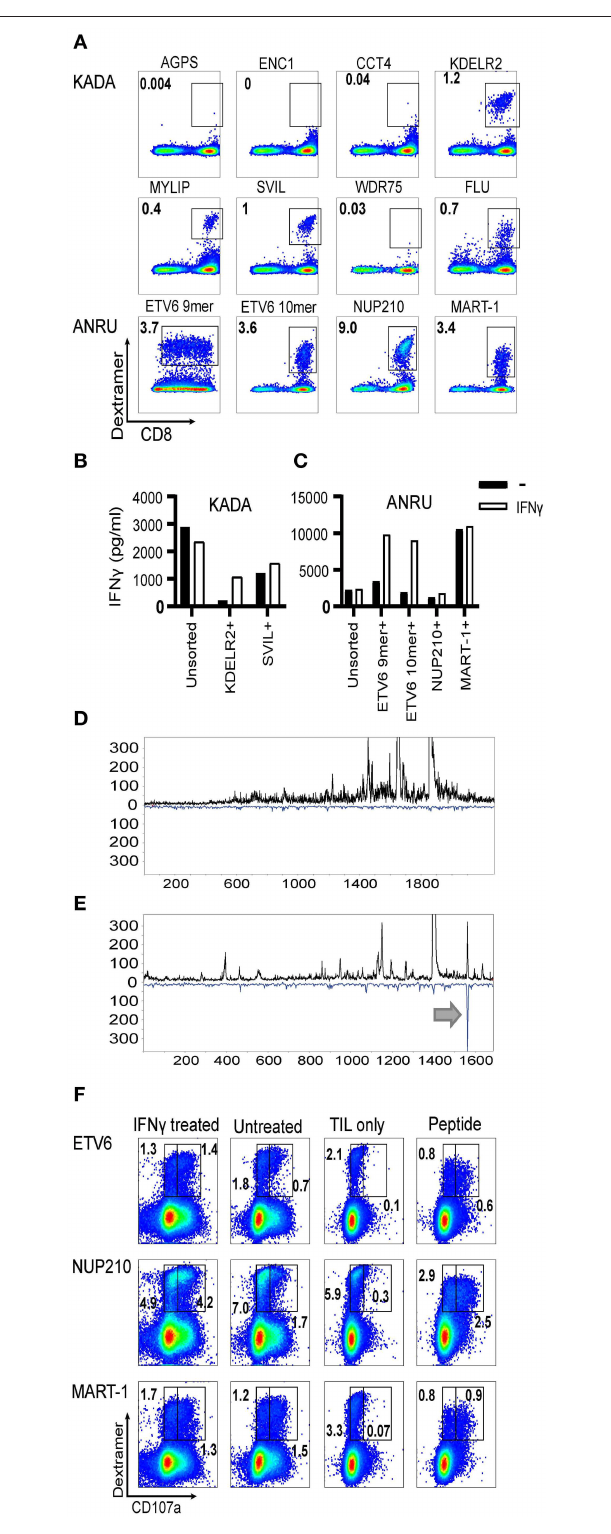
FIGURE 3 | Frequencies of neoantigen-specific T cells in TIL and assessment of their ability to recognize autologous tumor cells. HLA-A2/mutated